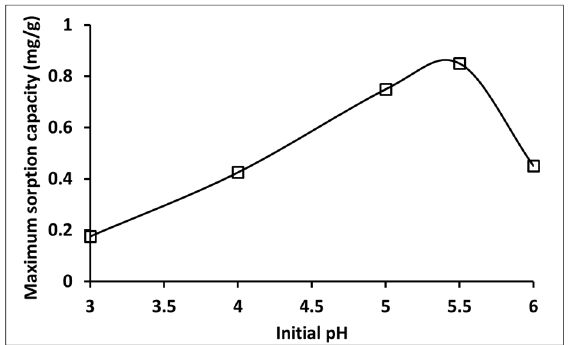
Fig. 3. Effect of initial pH on the removal of Cr(III) from aqueous